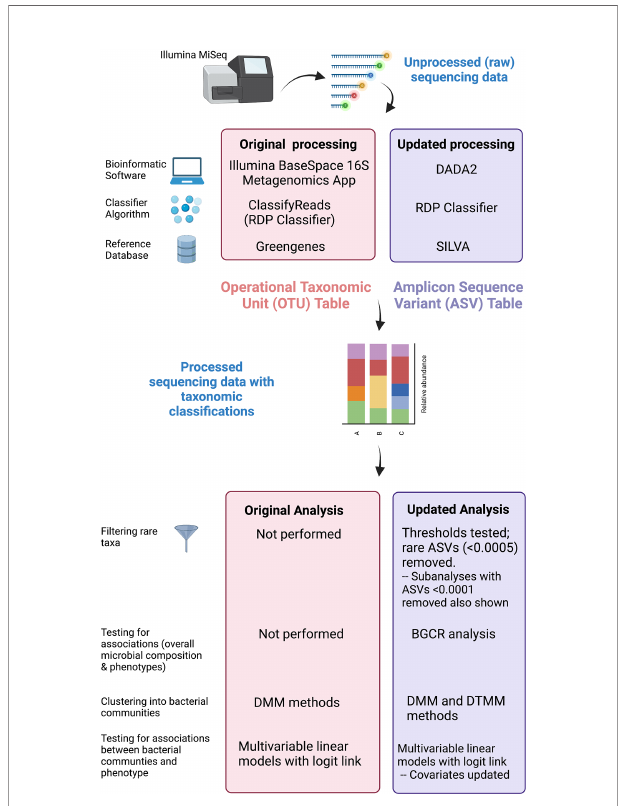
FIGURE 2 | Comparison of original and updated methods. Unprocessed sequencing data generated from an Illumina MiSeq platform were obtained. The fi gure illustrates differences in the bioinformatic software, classifying algorithm, and reference databases between original and updated processing. The output from original processing was an OTU table. The output from updated processing was an ASV table, which is similar to an OTU table but also adjusts for sequencing errors. Both tabular outputs can be incorporated into Phyloseq objects in R to visualize data as stacked bar plots. Original and updated statistical analysis methods including fi ltering, clustering, and methods used to test for associations are also listed. Created with